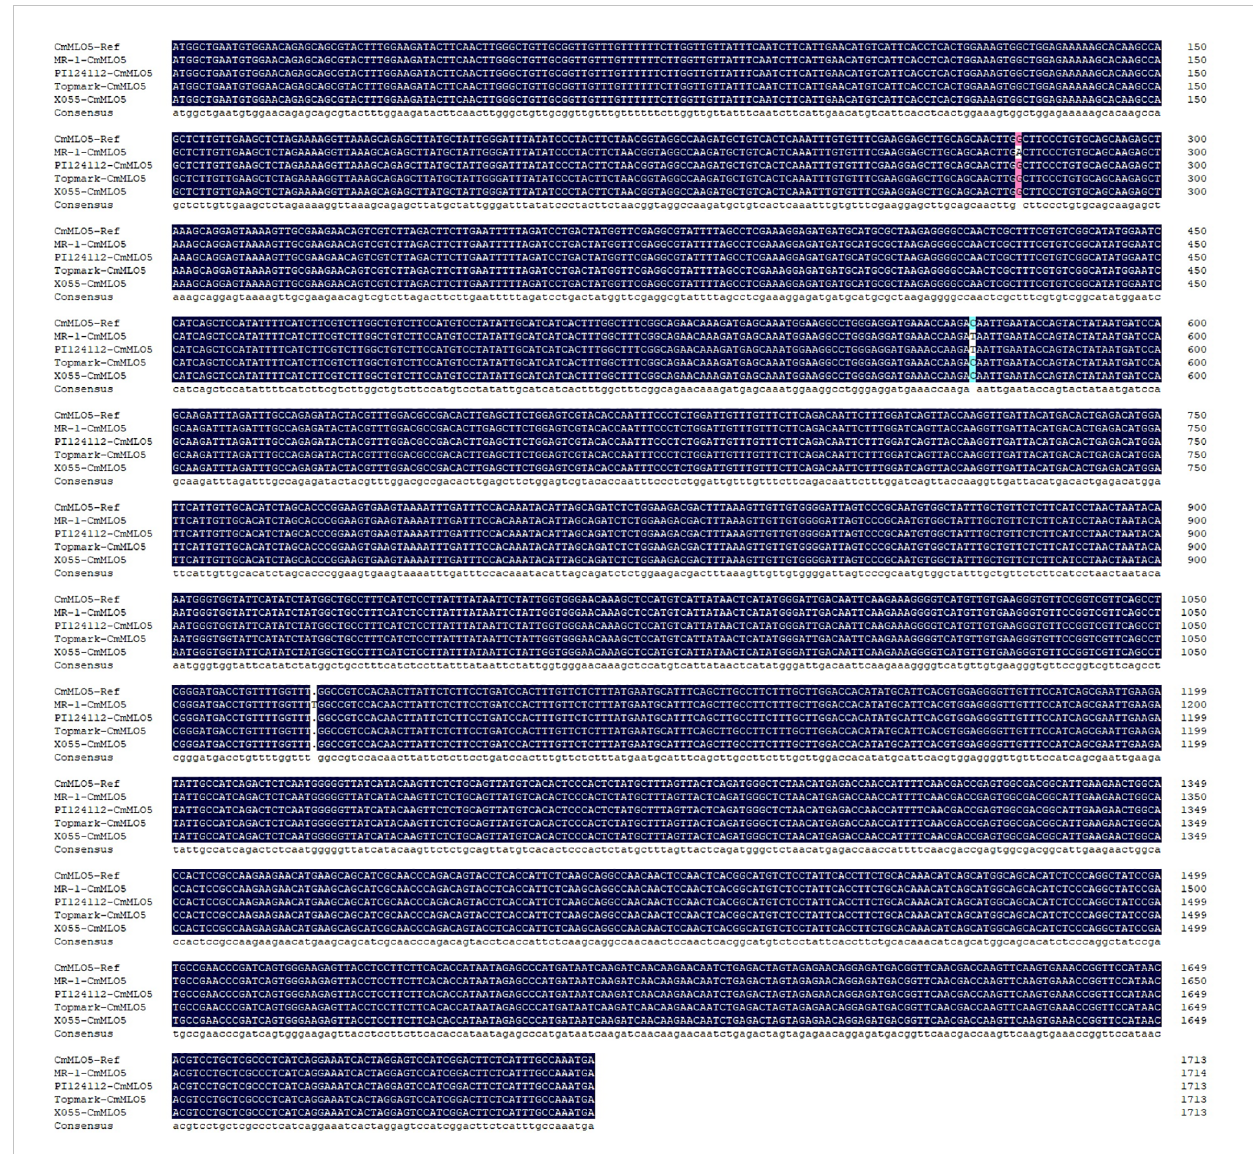
FIGURE 9 Multiple sequence alignment of the CmMLO5 gene in four melon lines (MR-1, PI124112, X055, and Topmark),